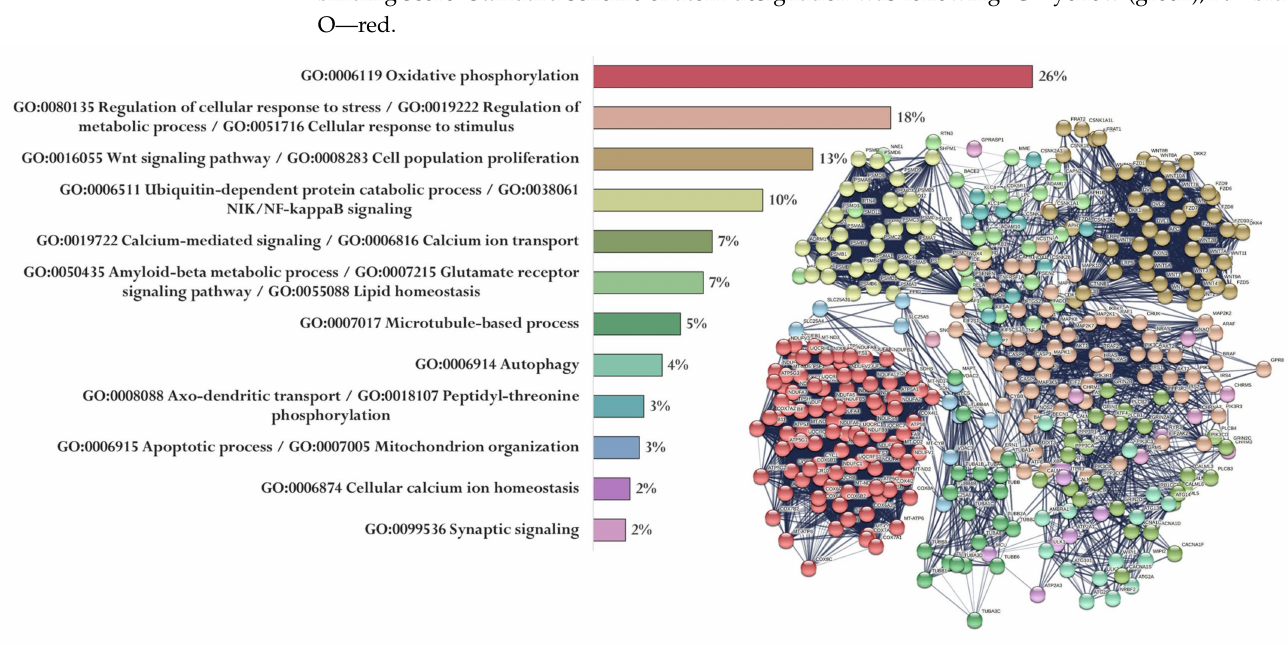
Figure 4. Functional relationship of proteins encoded by AD-associated genes according to the PathCards database [144]. Proportion of proteins in functional clusters ( left ). Protein–protein interaction networks ( right